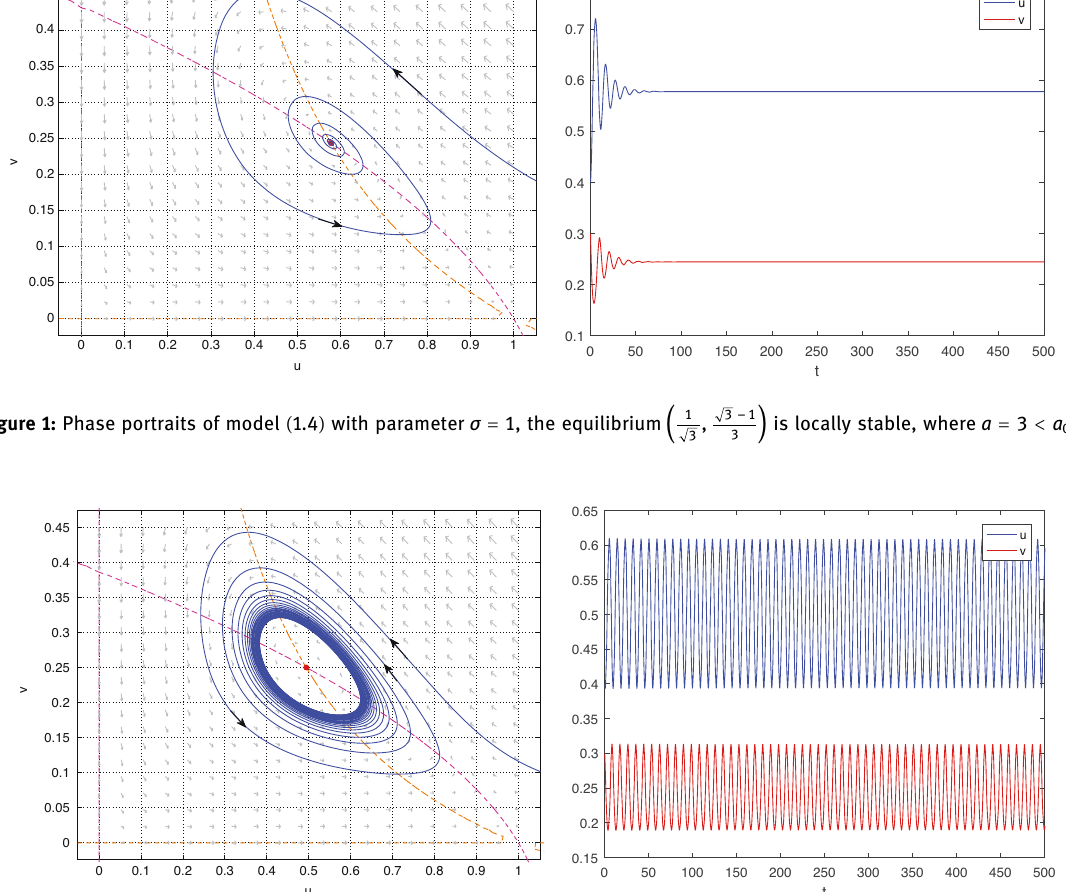
Figure 2: Phase portraits of model ( 1.4 ) with parameter = σ 1 , the bifurcating periodic solution is stable, where =